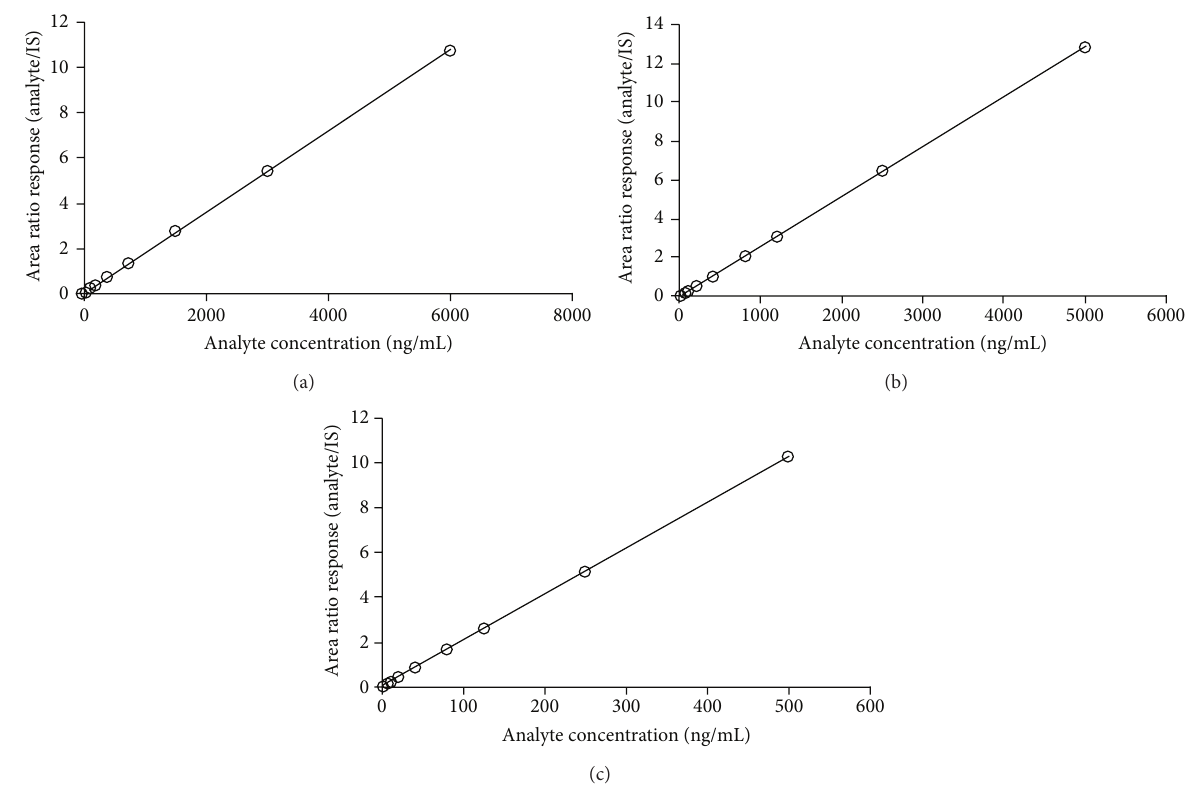
Figure 1: Calibration curves for (a) atazanavir, (b) darunavir, and (c) ritonavir. Table 2: Intrabatch and interbatch precision and accuracy for atazanavir, darunavir, and